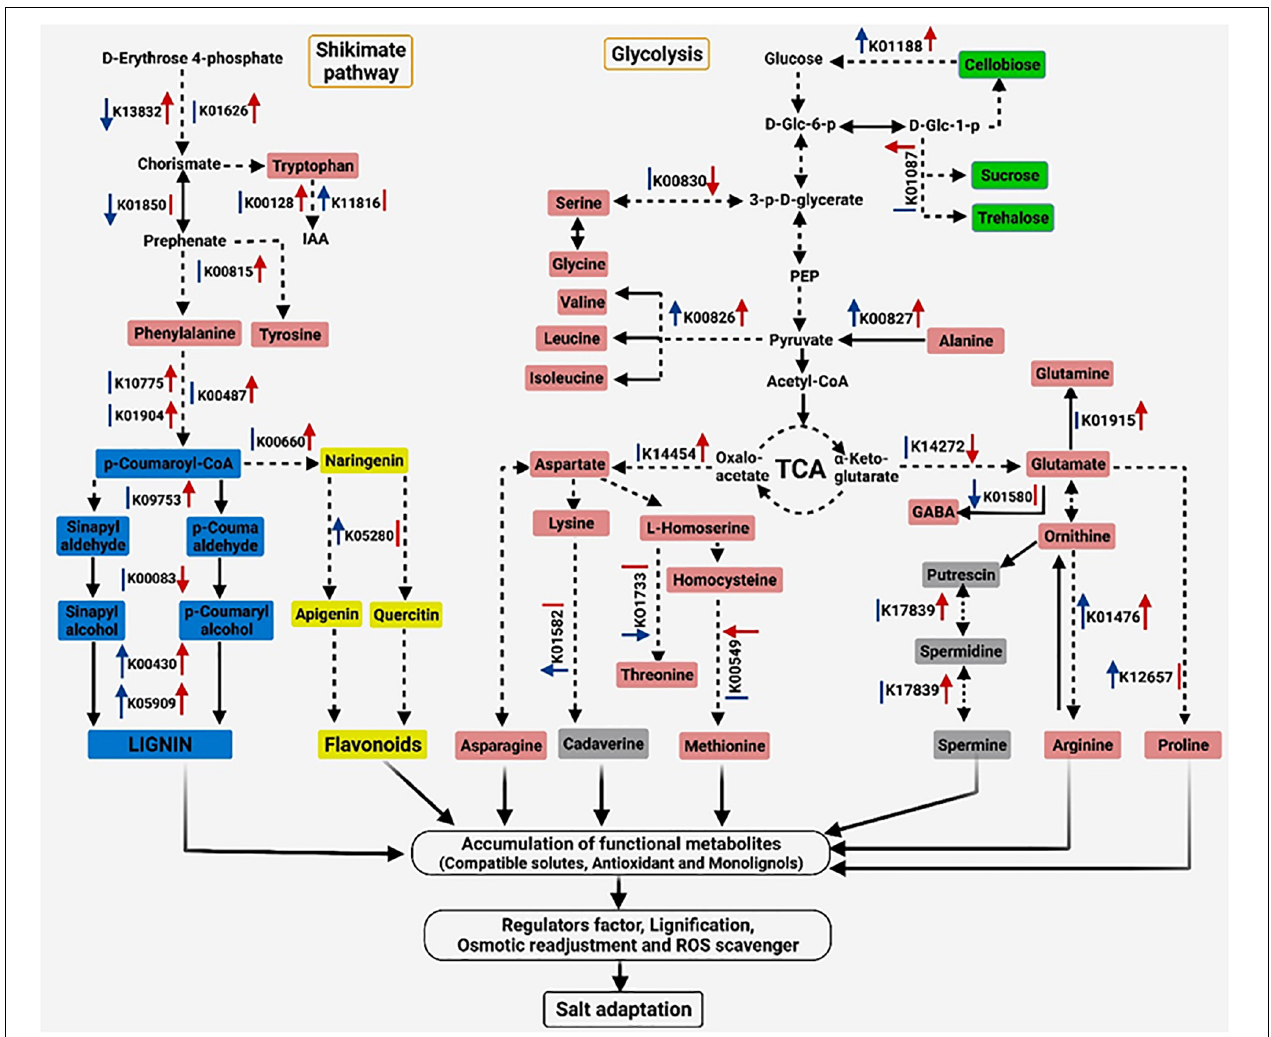
FIGURE 10 | Proposed schematic of the adaptive mechanism in S. argel plants exposed to salt conditions. The red arrow on the right of each Kyoto Encyclopedia of Genes and Genomes (KEGG) number indicates a change in the gene expression level in the leaves and blue on the left indicates a change in the gene expression level in the roots; up arrows indicate upregulation while down arrows indicate downregulation with q value ≤ 0.05, except five genes (K00830, K01476, K01580, K01733, and K14454) with P -value ≤ 0.05, and the lines indicate no change. Different colors are used to show amino acids (pink), PAs (gray), flavonoids (yellow), phenylpropanoids (blue), disaccharides (green), and other metabolites (without color), i.e., IAA, Indole-3-acetic acid; D-Glc-6-p, D-Glucose 6-phosphate; D-Glc-1-p, D-Glucose 1-phosphate; 3-p-D-glycerate, 3-Phospho-D-glycerate; and PEP,